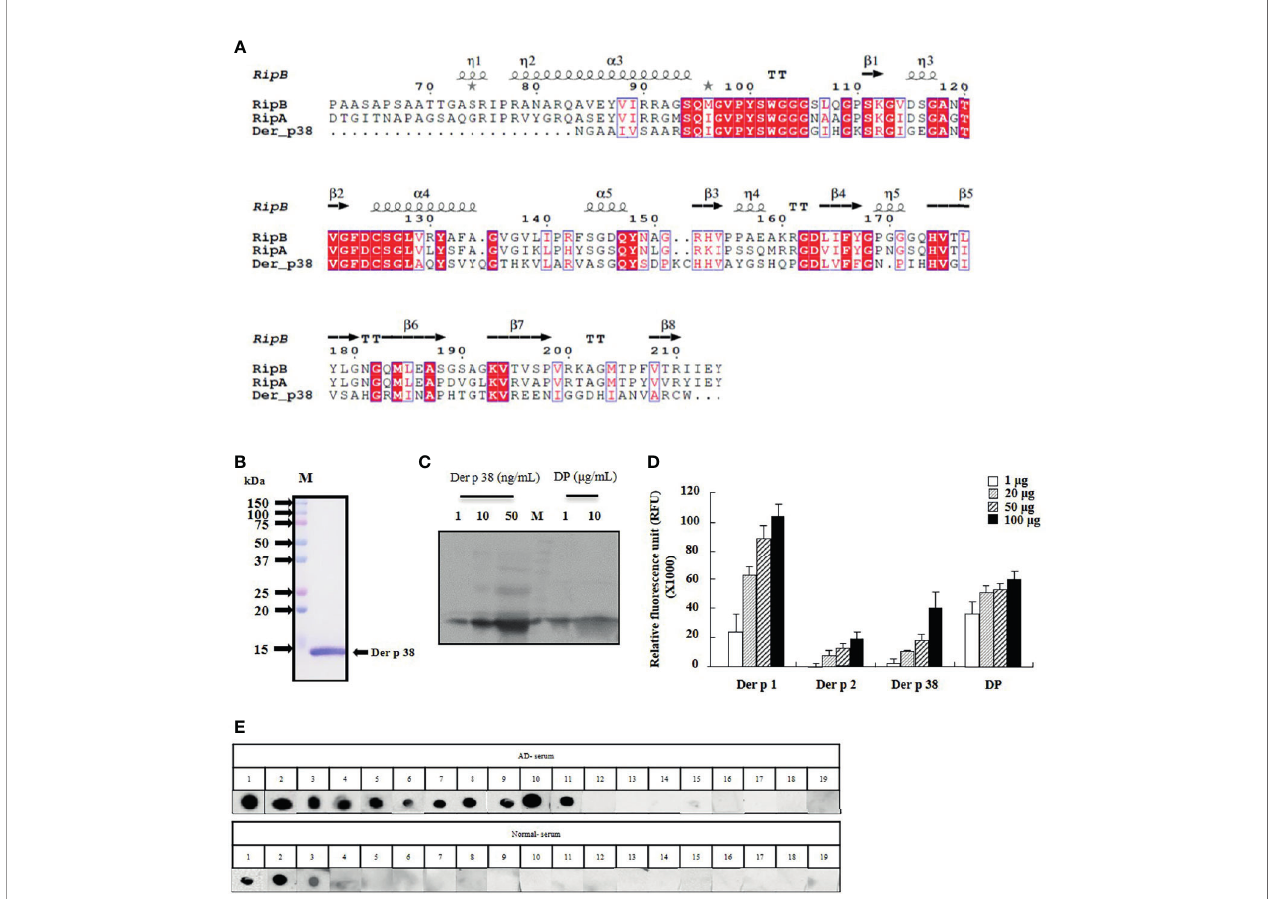
protease activity kit. (E) Dot blot assay was performed with sera of healthy and AD